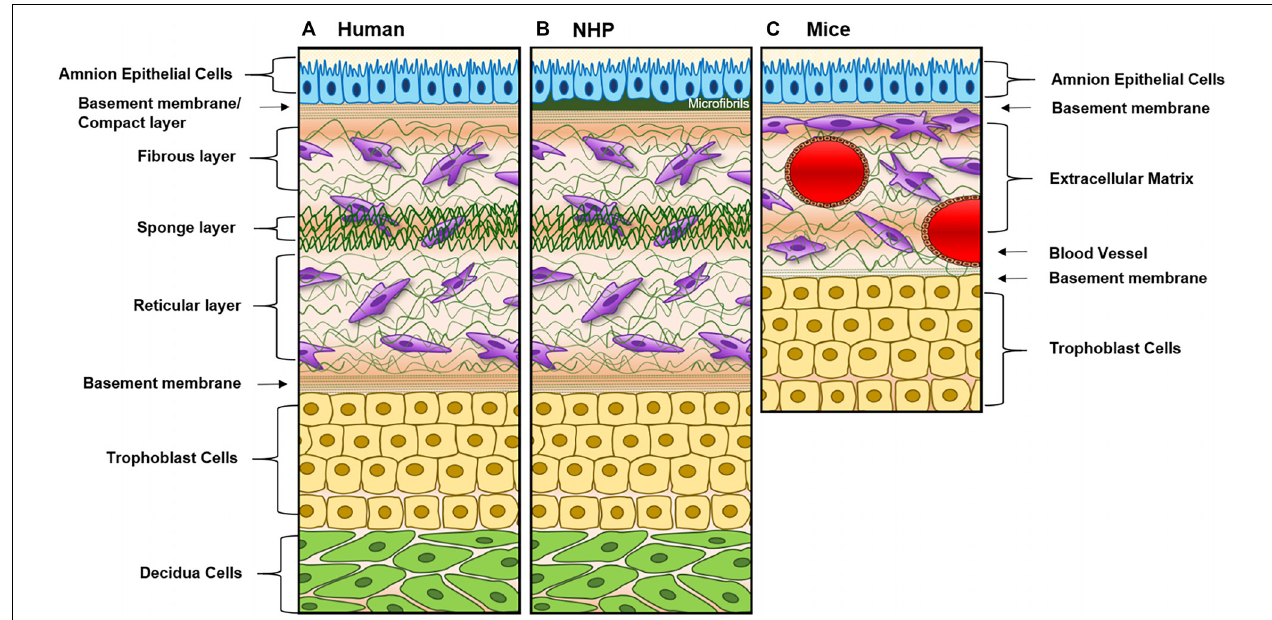
FIGURE 3 | Diagram of fetal membranes anatomical differences between species. (A) Illustration representing the human fetal membrane. The human fetal membrane, or feto-maternal interface, starts with the innermost layer (amnion) facing the amniotic cavity and ends with the maternal decidua. Within the intrauterine cavity, the amnion epithelial cells (AECs) connected to the basement membrane (green stripes) are bathed in amniotic fluid (yellow) and comprise the first layer. Below AECs, the ECM is comprised of compact, fibrous, spongy, and reticular layers, all containing mesenchymal cells derived from the amnion and chorion (purple). Chorion trophoblast cells (CT; yellow) are attached to the ECM via another layer of the basement membrane on its apical side and to the maternal decidua (green) on its basal side. (B) Schematic of non-human primate (NHP) fetal membranes, currently the best animal model used in the field. It is almost identical to human fetal membranes; however, specific to NHPs, the AEC layer interfaces with a thick, fibrous, collagen layer termed “microfibers” (Owiti et al., 1989) before the basement membrane/compact layer of the ECM. (C) The amniotic sac of a mouse is comprised of two epithelial layers; amnion epithelial monolayer (blue) and a multilayer of chorion trophoblast cells (yellow). Between these layers, loose collagen fibers support mesenchymal cells (purple) and maternal blood vessels in the ECM. This tissue does not contain a maternal interface (i.e., decidua) as other mammalian